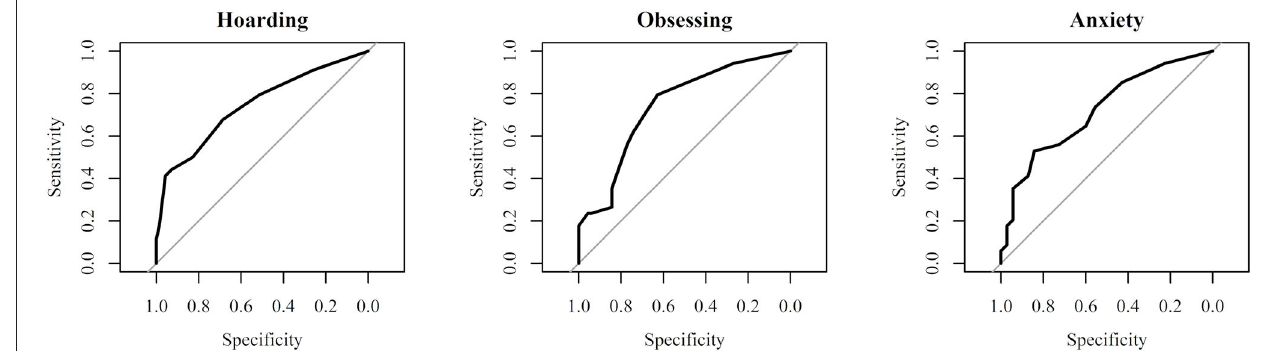
FIGURE 2 | Receiver Operating Characteristic (ROC) plots for hoarding, obsessing, and depression symptoms. Larger areas under the curve indicate better global performance of the variable in discriminating individuals with mild to moderate Internet Use Disorder (IUD) from